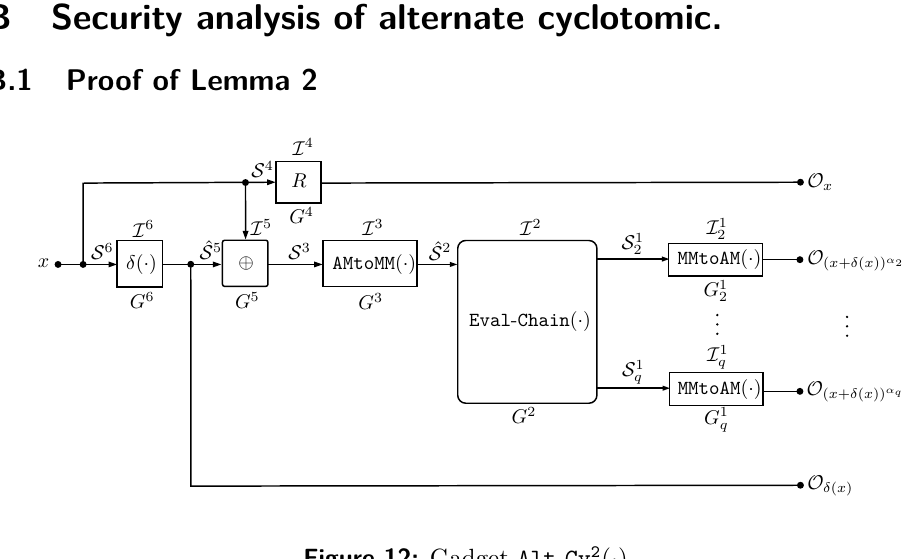
Figure 12: Gadget Alt - Cy 2 ( ·